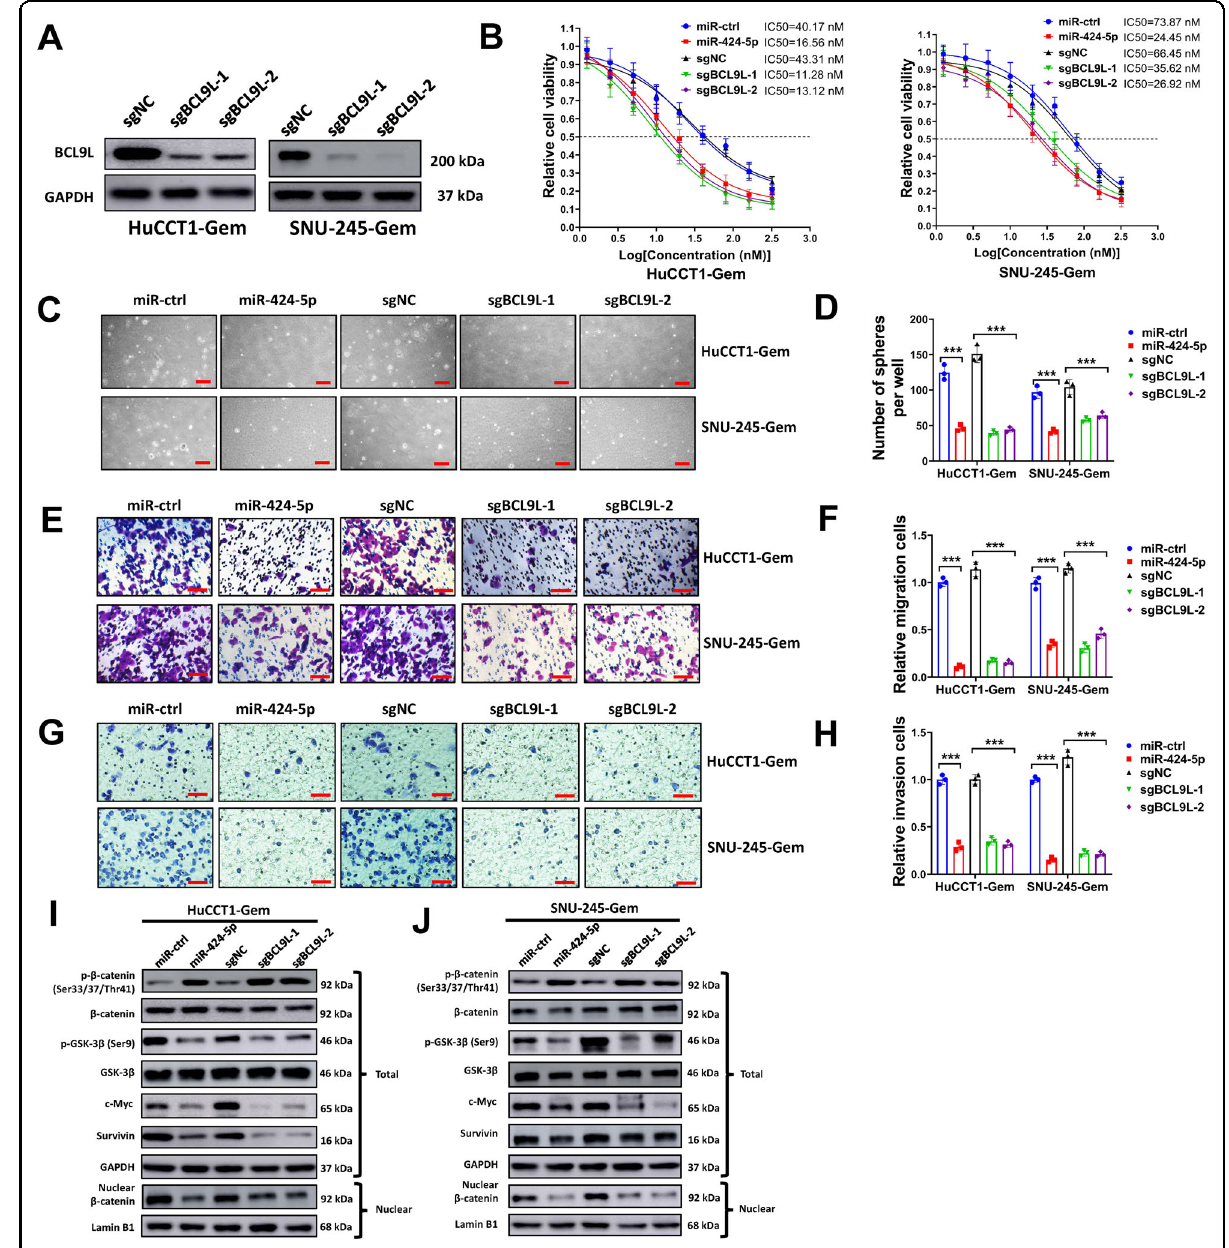
Fig. 7 Enforced miR-424-5p expression or silencing BCL9L suppresses gemcitabine resistance, EMT, stemness, and Wnt/ β -Catenin signaling activation in resistant CCA cells. A HuCCT1-Gem and SNU-245-Gem cells were transduced with sgBCL9L-1, sgBCL9L-2, or sgNC, then BCL9L expression was evaluated by western blot. B HuCCT1-Gem and SNU-245-Gem cells were transduced sgBCL9L-1, sgBCL9L-2, sgNC, miR-424-5p or miR-ctrl, then cells were seeded in 96-well plates (5000 cells/well) and exposed to 0, 1.25, 2.50, 5.0, 6.25, 10, 20, 40, 80, 160, and 320 nM gemcitabine for 6 d, and assayed for cell viability. C – J HuCCT1-Gem and SNU-245-Gem cells were transduced sgBCL9L-1, sgBCL9L-2, sgNC, miR-424-5p or miR-ctrl, the cells were used for sphere formation assay ( C , D ), transwell cell migration ( E , F ) and invasion ( G , H ) assay, and western blot analysis of indicated genes in Wnt/ β -Catenin pathway ( I , J ). Scale bars = 100 μ m for sphere formation assay, and scale bars = 50 μ m for transwell cell migration and invasion assay. *** P ≤